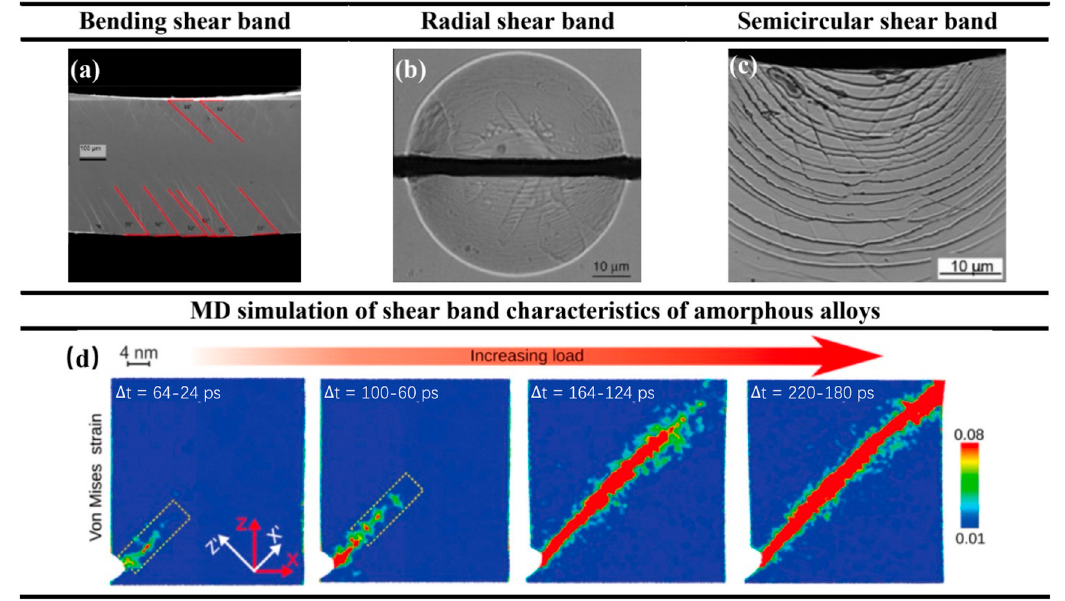
Figure 4. ( a ) Bending shear band, adapted with permission from Ref. [22] 2011, Elsevier. ( b ) Radial shear band. ( c ) Semicircular shear band, adapted with permission from Ref. [23] 2011, Elsevier. ( d ) The shear band of amorphous alloys starts at the stress concentration at the root of the notch and extends along the plane of maximum shear stress, adapted with permission from Ref. [24] 2017, APS.